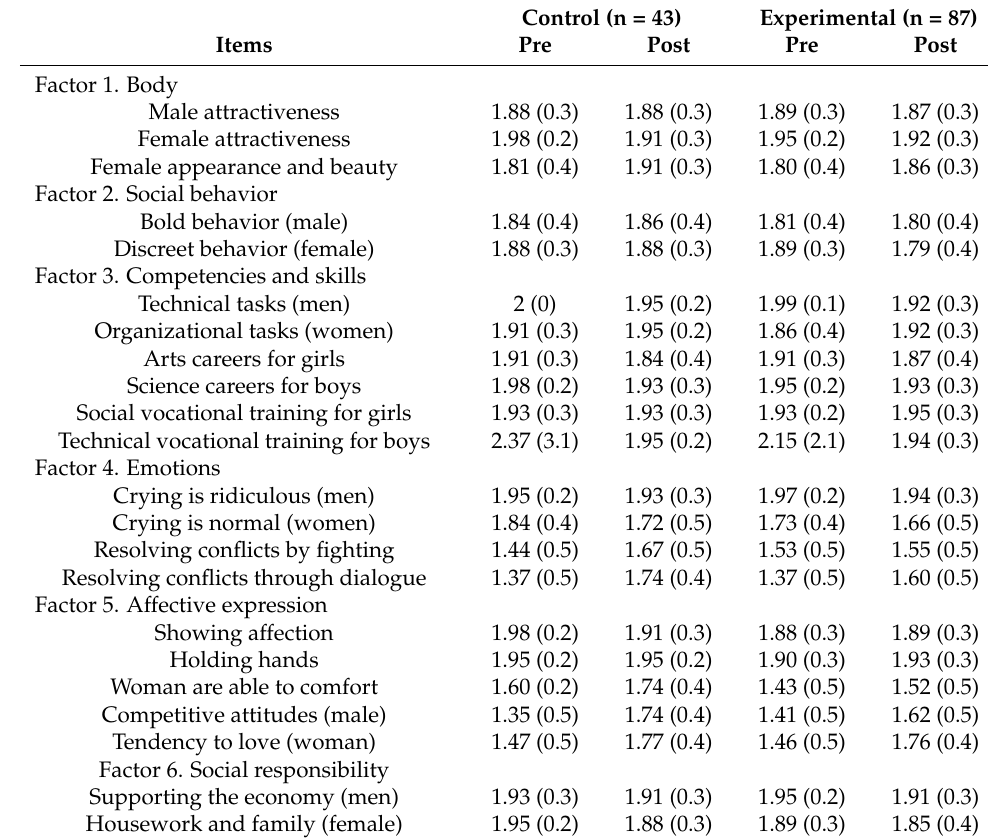
Table 2. Descriptive analysis of the data collection questionnaire on students’